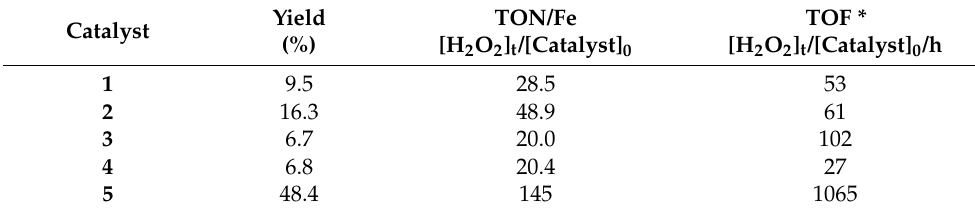
* Calculated from the V i values: TOF = 3600 × ( V i /2/[ 1 - 5 ]): [ 1 - 5 ] 0 = 1.0 × 10 − 3 M, [H 2 O 2 ] 0 = 300 × 10 − 3 M, T = 298 K.